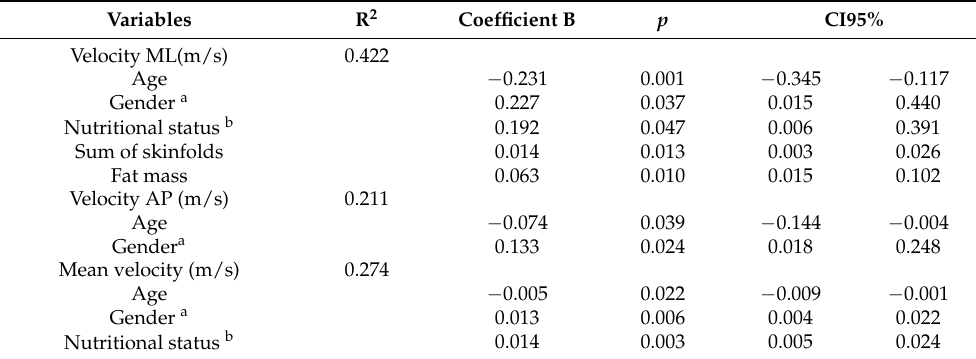
Table 3. Significant multiple linear regression models obtained for the COP variables in the eyes- open